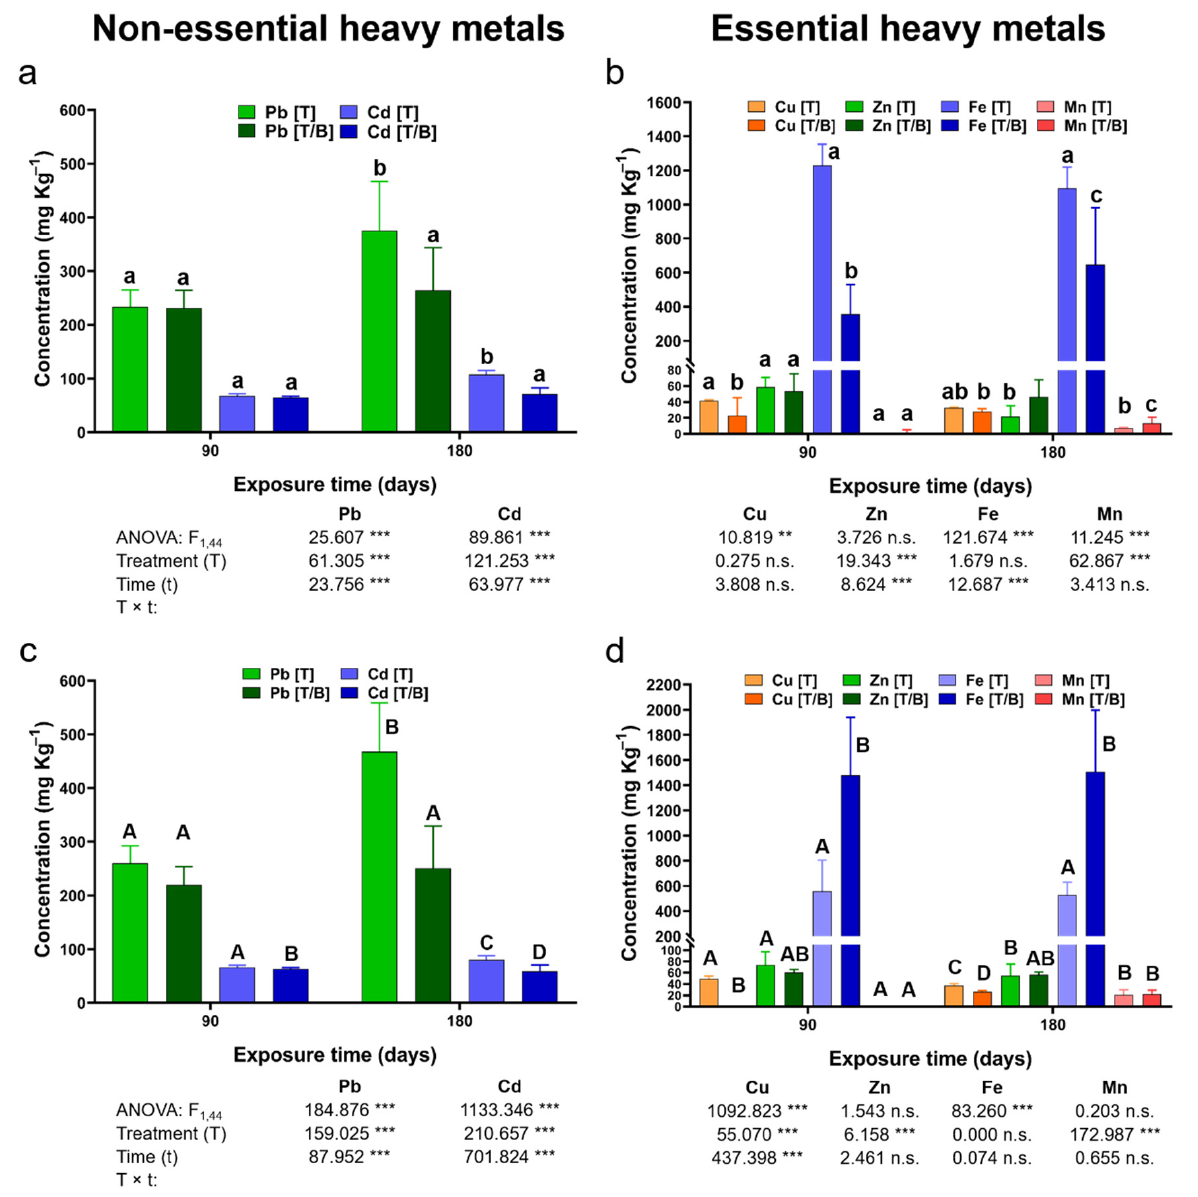
Figure 2. Average ± standard deviation and two-way ANOVA results for heavy metal concentration (mg Kg − 1 ) in roots ( a , b ) and leaves ( c , d ) of P. laevigata growing on tailing (T) and tailing/biochar (T/B) in in situ conditions during 90 and 180 days. Different lowercase letters denote significant differences among treatments in heavy metal root concentration (Tukey p < 0.05). Different uppercase letters denote significant differences among treatments in heavy metal leaves concentration (Tukey p <0.05), n.s. = not significant differences, ** = p < 0.01, *** = p < 0.001.